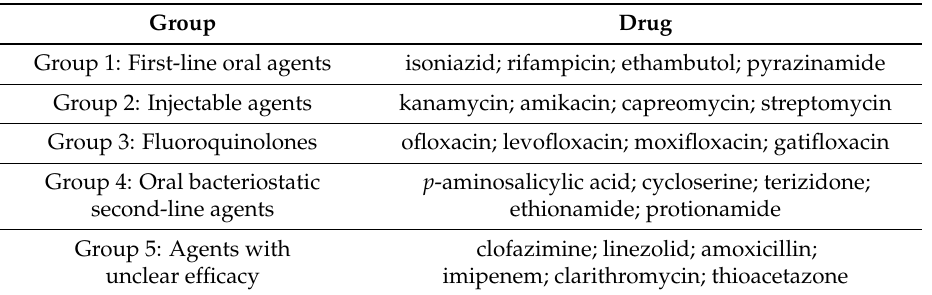
Table 1. Anti-tuberculosis drug classification, with inclusion of new compounds under evaluation a . Group Drug Group 1: First-line oral agents isoniazid; rifampicin; ethambutol; pyrazinamide Group 2: Injectable agents kanamycin; amikacin; capreomycin; streptomycin Group 3: Fluoroquinolones ofloxacin; levofloxacin; moxifloxacin; gatifloxacin p -aminosalicylic acid; cycloserine; terizidone; Group 4: Oral bacteriostatic second-line agents ethionamide; protionamide Group 5: Agents with clofazimine; linezolid; amoxicillin; unclear efficacy imipenem; clarithromycin; thioacetazone a According to Reference